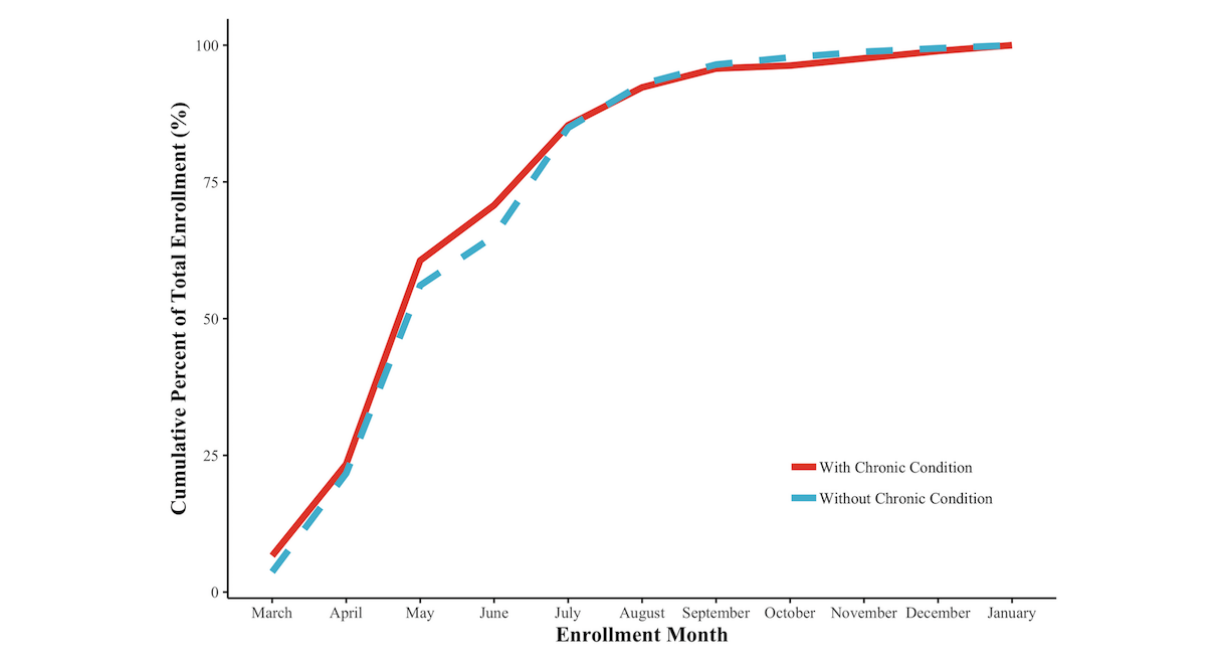
Figure 2. Cumulative enrollment in the pilot program for without chronic condition (dotted line) and chronic condition participants (solid line), March 2016 to January